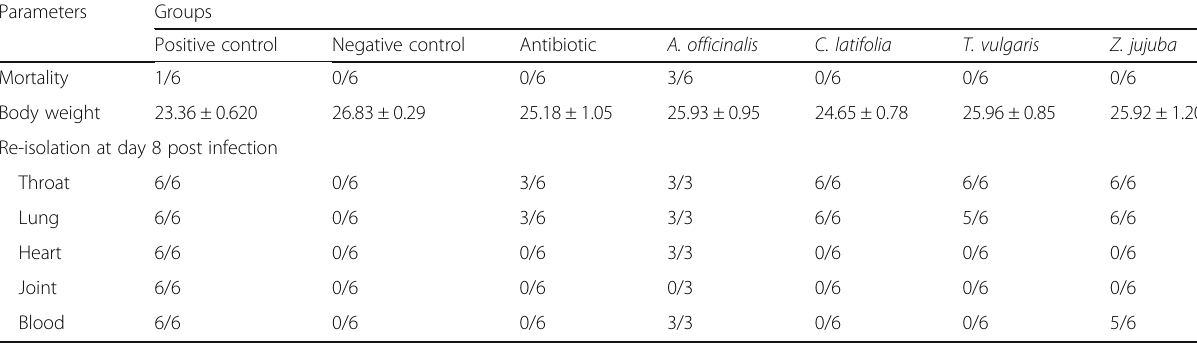
Table 3 Main study: Effects of plant extract treatment on clinical outcome of infected animals at 8 days post infection Parameters